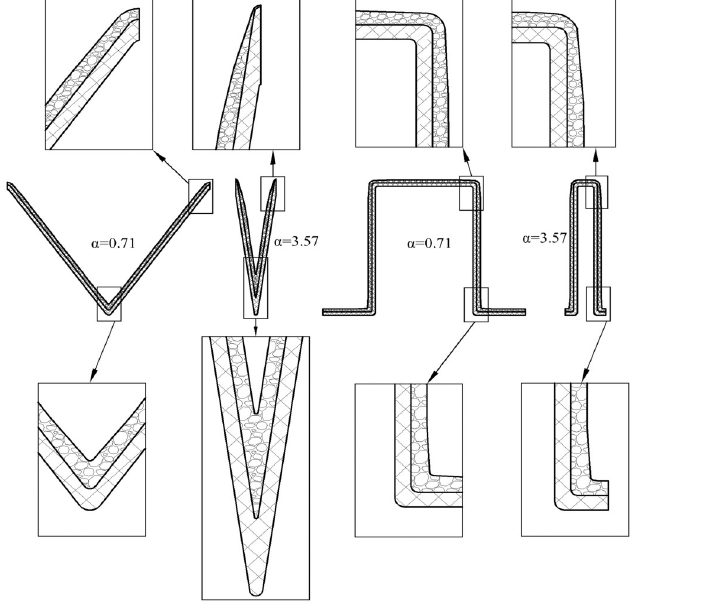
Fig 18. Unevenness of dust deposition when W equals 30 mg/cm 2